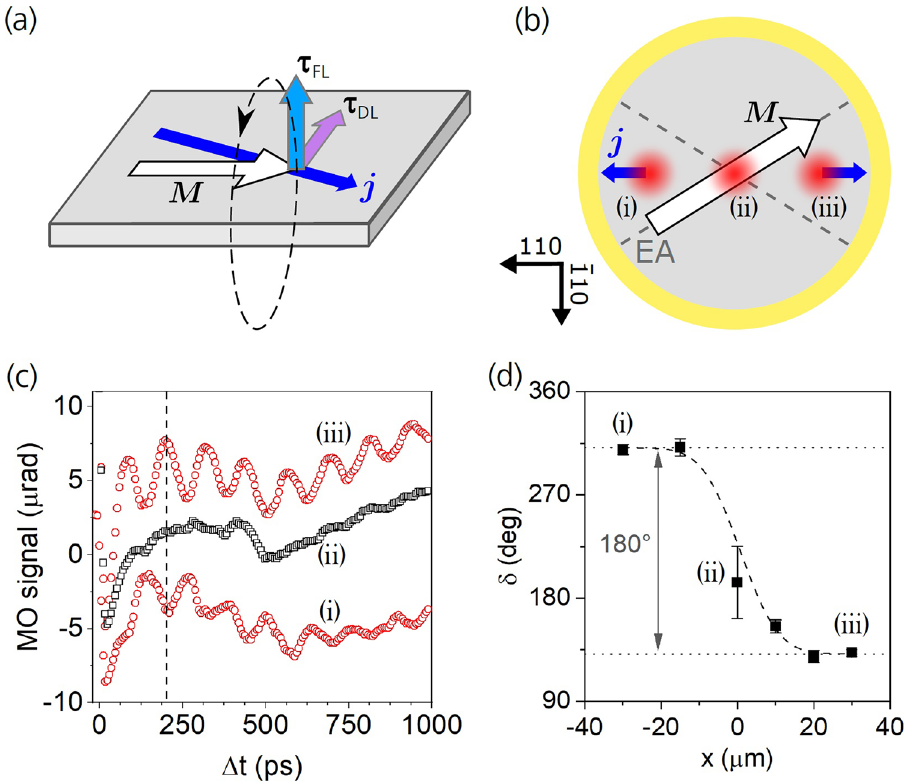
Figure 2. Magnetization precession induced by ultrashort SOT pulse. ( a ) Schematic illustration of the two possible SOT contributions acting on magnetization ( M ) due to the photocurrent pulse ( j ): field-like ( τ FL ) and damping-like ( τ DL ) torques. The two orthogonal torques lead to magnetization precessions (dashed ellipse) that differ by 90° in the initial phase. (b) Sketch of the photodiode with three positions located in the device center and ± 30 µm away from the center along the [110] crystallographic direction, which were investigated by the spatially-overlapped pump and probe laser spots. The net photocurrents in positions (i) and (iii) are opposite due to the location of the annular Au contact. No net lateral photocurrent is generated in position (ii). The experiment was performed with no external magnetic field applied when M was oriented along one of the easy axes (EA), which are indicated by the dashed lines. (c) Magnetization precession measured in the three positions indicated in ( b ) for applied bias of − 10 V; the curves are vertically shifted for clarity. The precessional signal is correlated with the polarity and magnitude of the lateral current pulse. (d) Points: initial precessional phase δ as a function of the laser spots position x within the photodiode. The value δ ≈ 135° for x > 0 indicates the presence of damping-like SOT, as discussed in the text. Dashed line: fit by a step-like function smeared out by the Gaussian laser beam profile with ≈ 25 µm